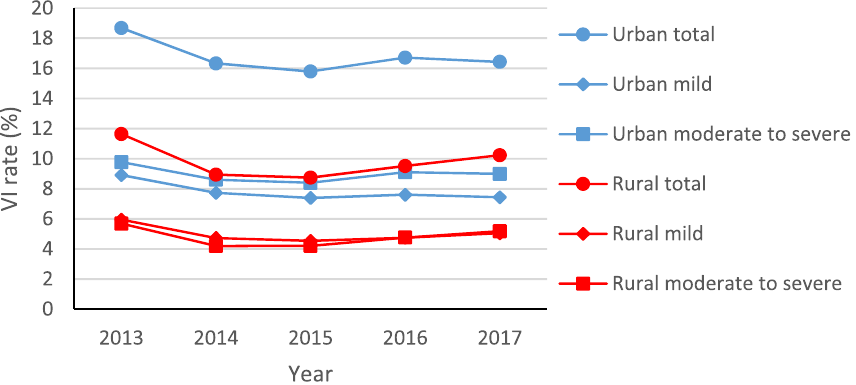
Figure 2. Trends in urban and rural visual impairment (VI) among children in Shandong province from 2013 to 2017.